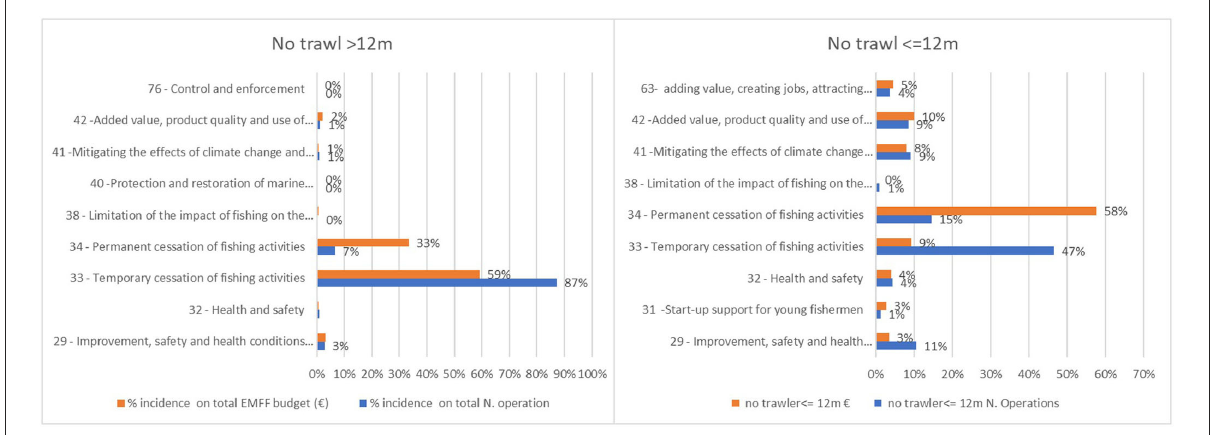
FIGURE5 EMMF measures allocated to vessels not equipped with trawl nets. Elaboration on data from the EMFF List of Operations and the EU Fleet Register of Italy, Croatia, Malta, Mediterranean Spain, and Mediterranean France.